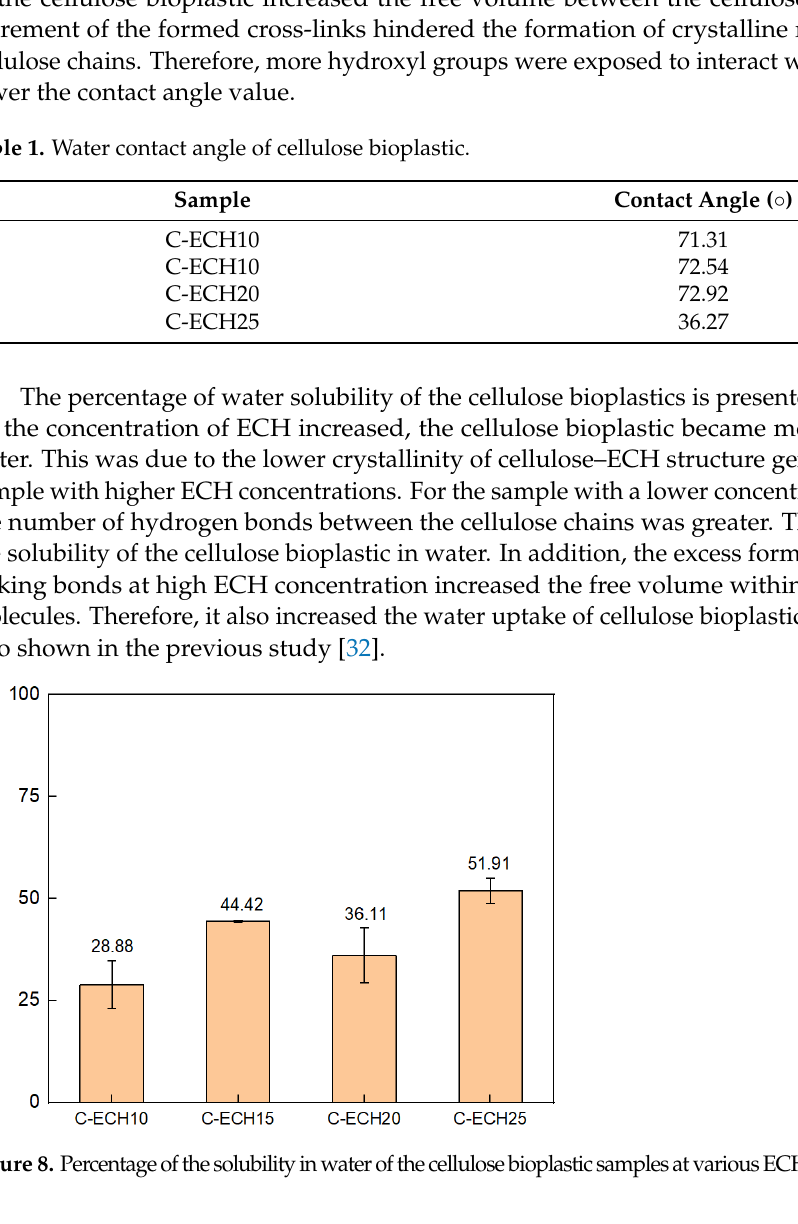
Figure 7. Water contact angle of ( a ) C-ECH10, ( b ) C-ECH15, ( c ) C-ECH20, ( d ) C-ECH25 samples.